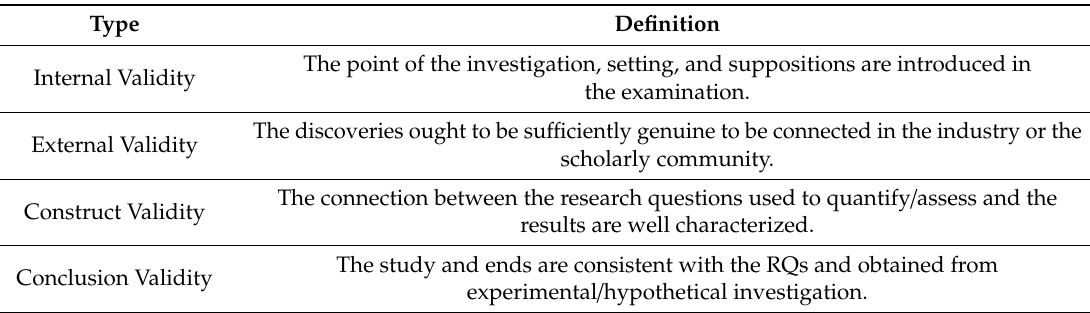
Table 4. Quality criteria for primary study selection.